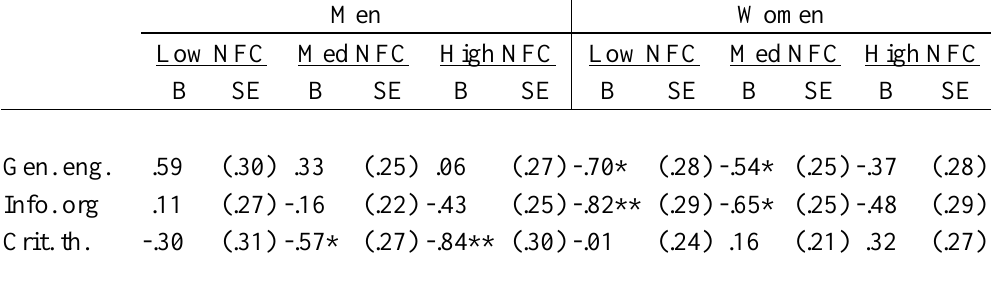
Study 1 gender-specific effects (unstandardized B weights) of discussion during deliberation activities on closed-minded